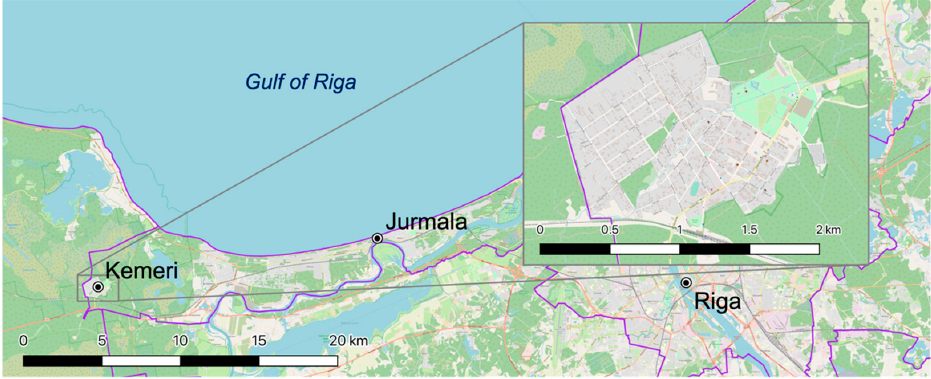
Figure 2. Location of the study area (basemap taken from [22]).